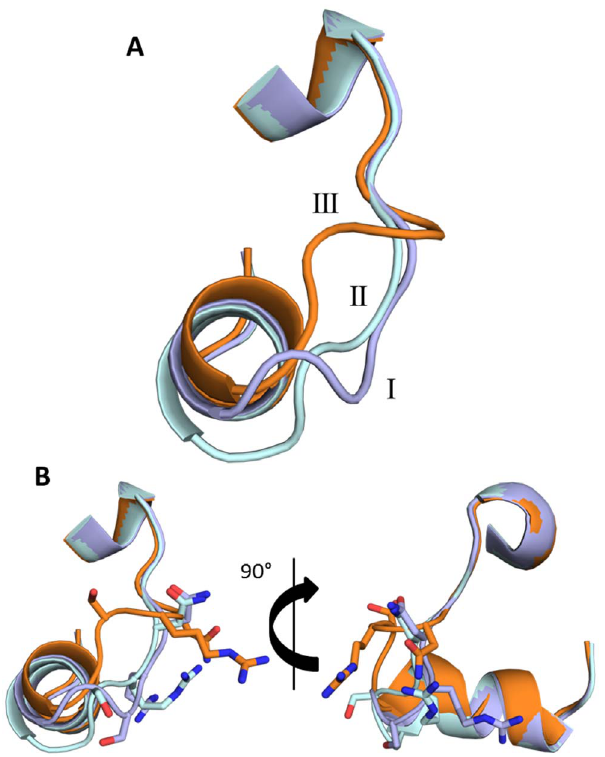
Figure 3. Coordination of the sulphate ion required in the crystal structure. Top panel shows the asymmetric unit of the C.Esp1396I high resolution wild type X-ray crystal structure (4I6R) in orange with a symmetry related dimer in light orange. The sulphate ion is shown in pink. The zoom shows atoms hydrogen bonding directly to the sulphate including water molecules (dark blue spheres). Hydrogen bonds are shown as grey dashed lines.